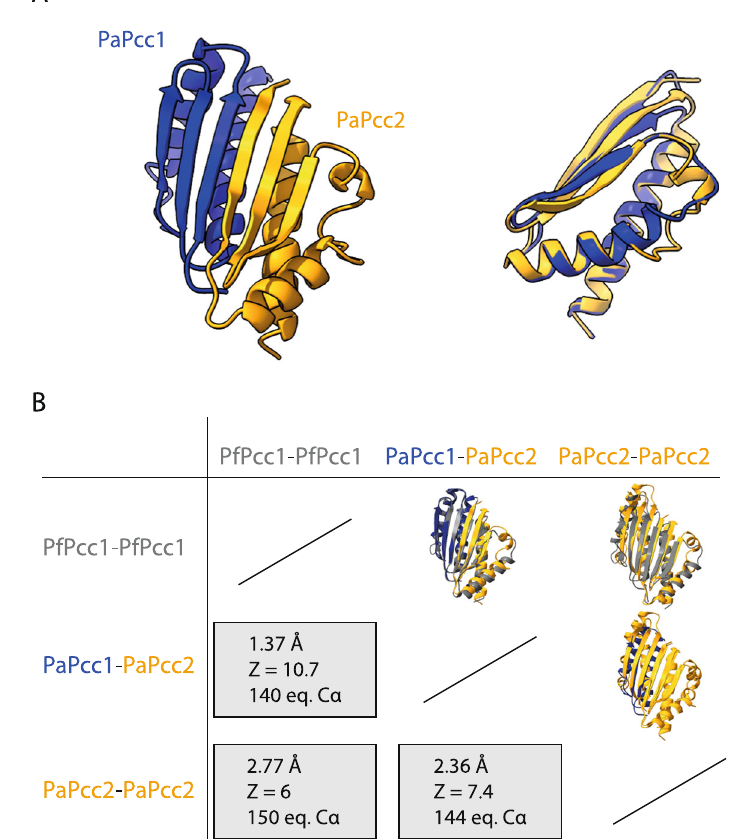
Fig. 5 | CrystalstructureofPaPcc1-PaPcc2 heterodimer. A Cartoon presentation of PaPcc1-PaPcc2 structure (in blue and orange, respectively) is shown on the left andthesuperpositionofPaPcc2ontoPaPcc1isontheright. B Pairwisecomparison